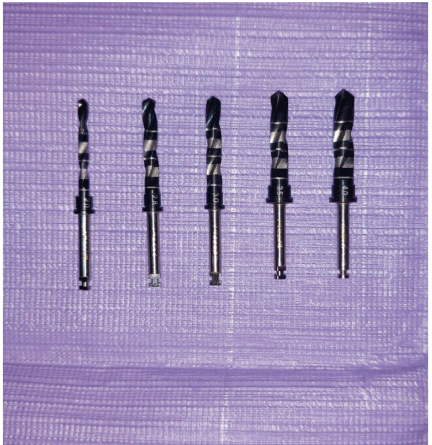
Figure 2: Gradual implant drills for the final implant bed for 4.25Ø mm implant; the gradual drill designs contain twisted flutes and only the pilot drill have a working tip (GMI, Frontier).